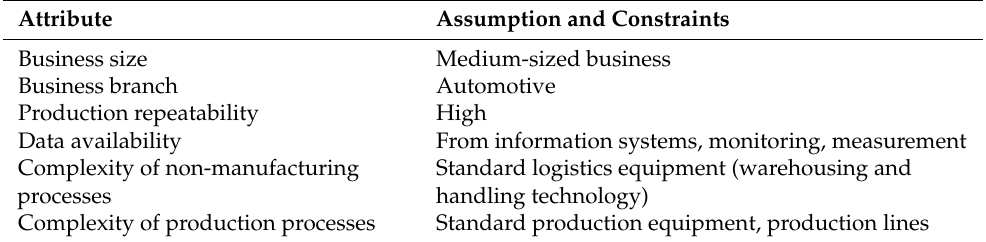
Table 2. Main attributes of the